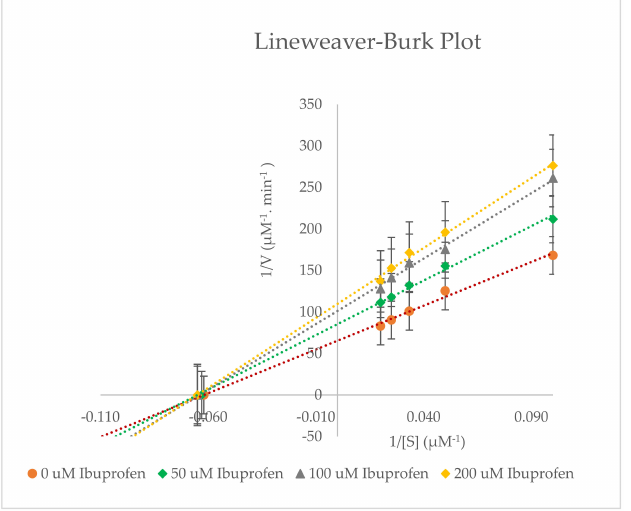
Figure 5. Lineweaver − Burk plot for the inhibition of CYP3A2 − mediated dexamethasone metabolism by various concentrations of ibuprofen (0 − 200 µ M) in rat liver microsomes. Values are expressed as the average of triplicate measurements.